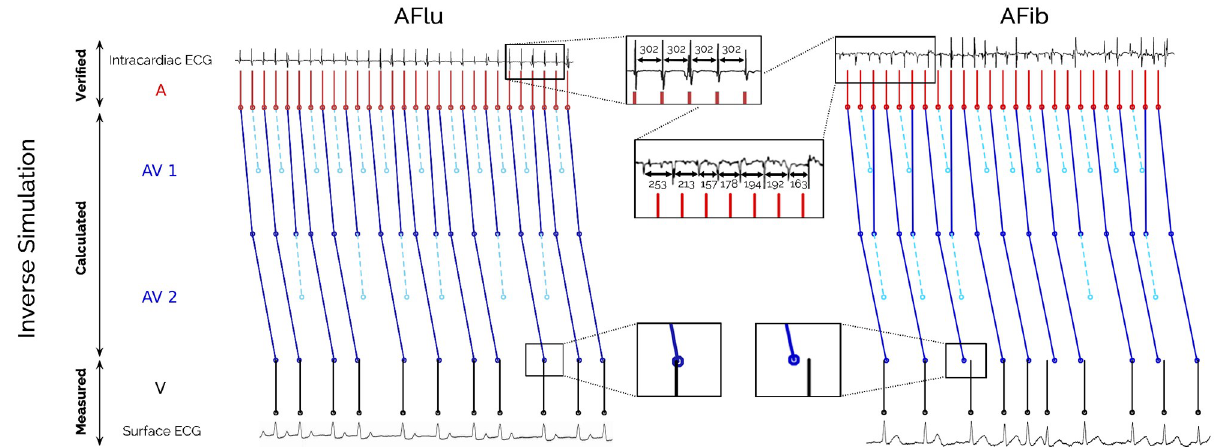
Fig 2. Visualization of our inverse simulation approach applied to samples of atrial flutter (AFlu, left, regular intracardiac measurement) versus atrial fibrillation (AFib, right, irregular intracardiac measurement) based on the surface electrocardiogram (ECG, bottom). In this example, a two-level atrioventricular (AV) block was calculated for both